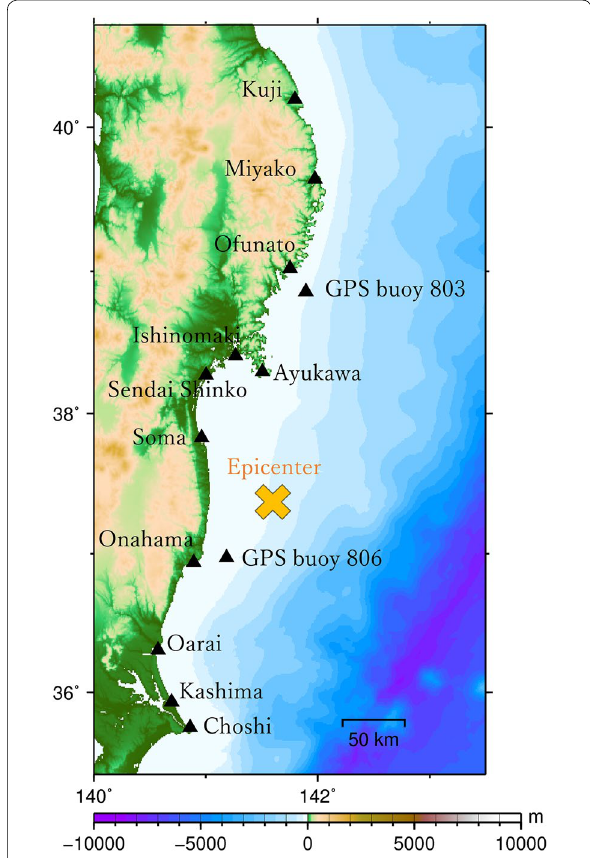
Fig. 1 Locations of the 22 November 2016 event epicenter, tide gauge stations, and GPS buoys. Stations Kuji, Ishinomaki, Sendai Shinko, Kashima, and both GPS buoys are operated by the Port Authority of the Ministry of Land, Infrastructure, Transport and Tourism; station Soma is operated by the Geographical Survey Institute; and stations Miyako, Ofunato, Ayukawa, Onahama, Oarai, and Choshi are operated by the Japan Meteorological